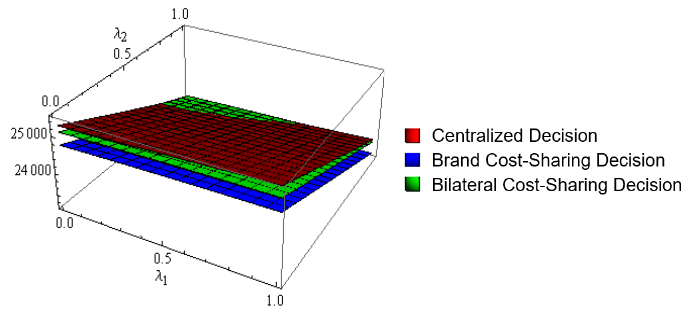
Figure 5. Impact of λ i on the Supply Chain Profit When P 1 < P ∗ .